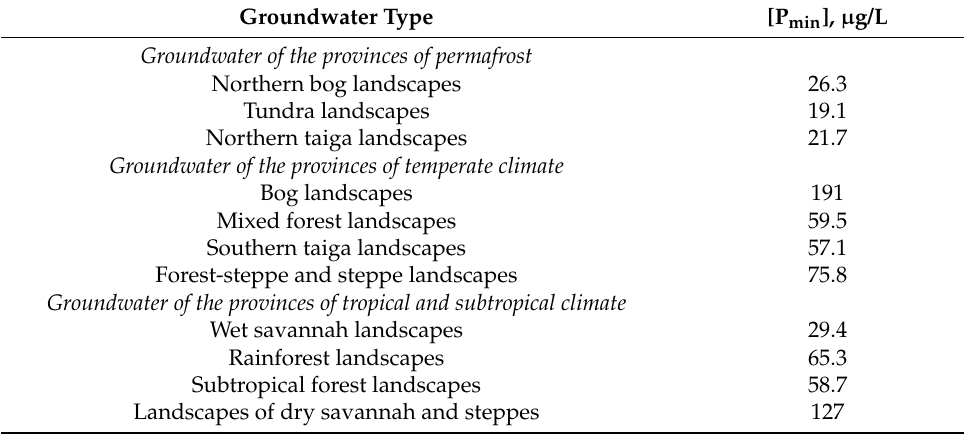
Table 13. The content of dissolved phosphorus in groundwater of the Critical Zone